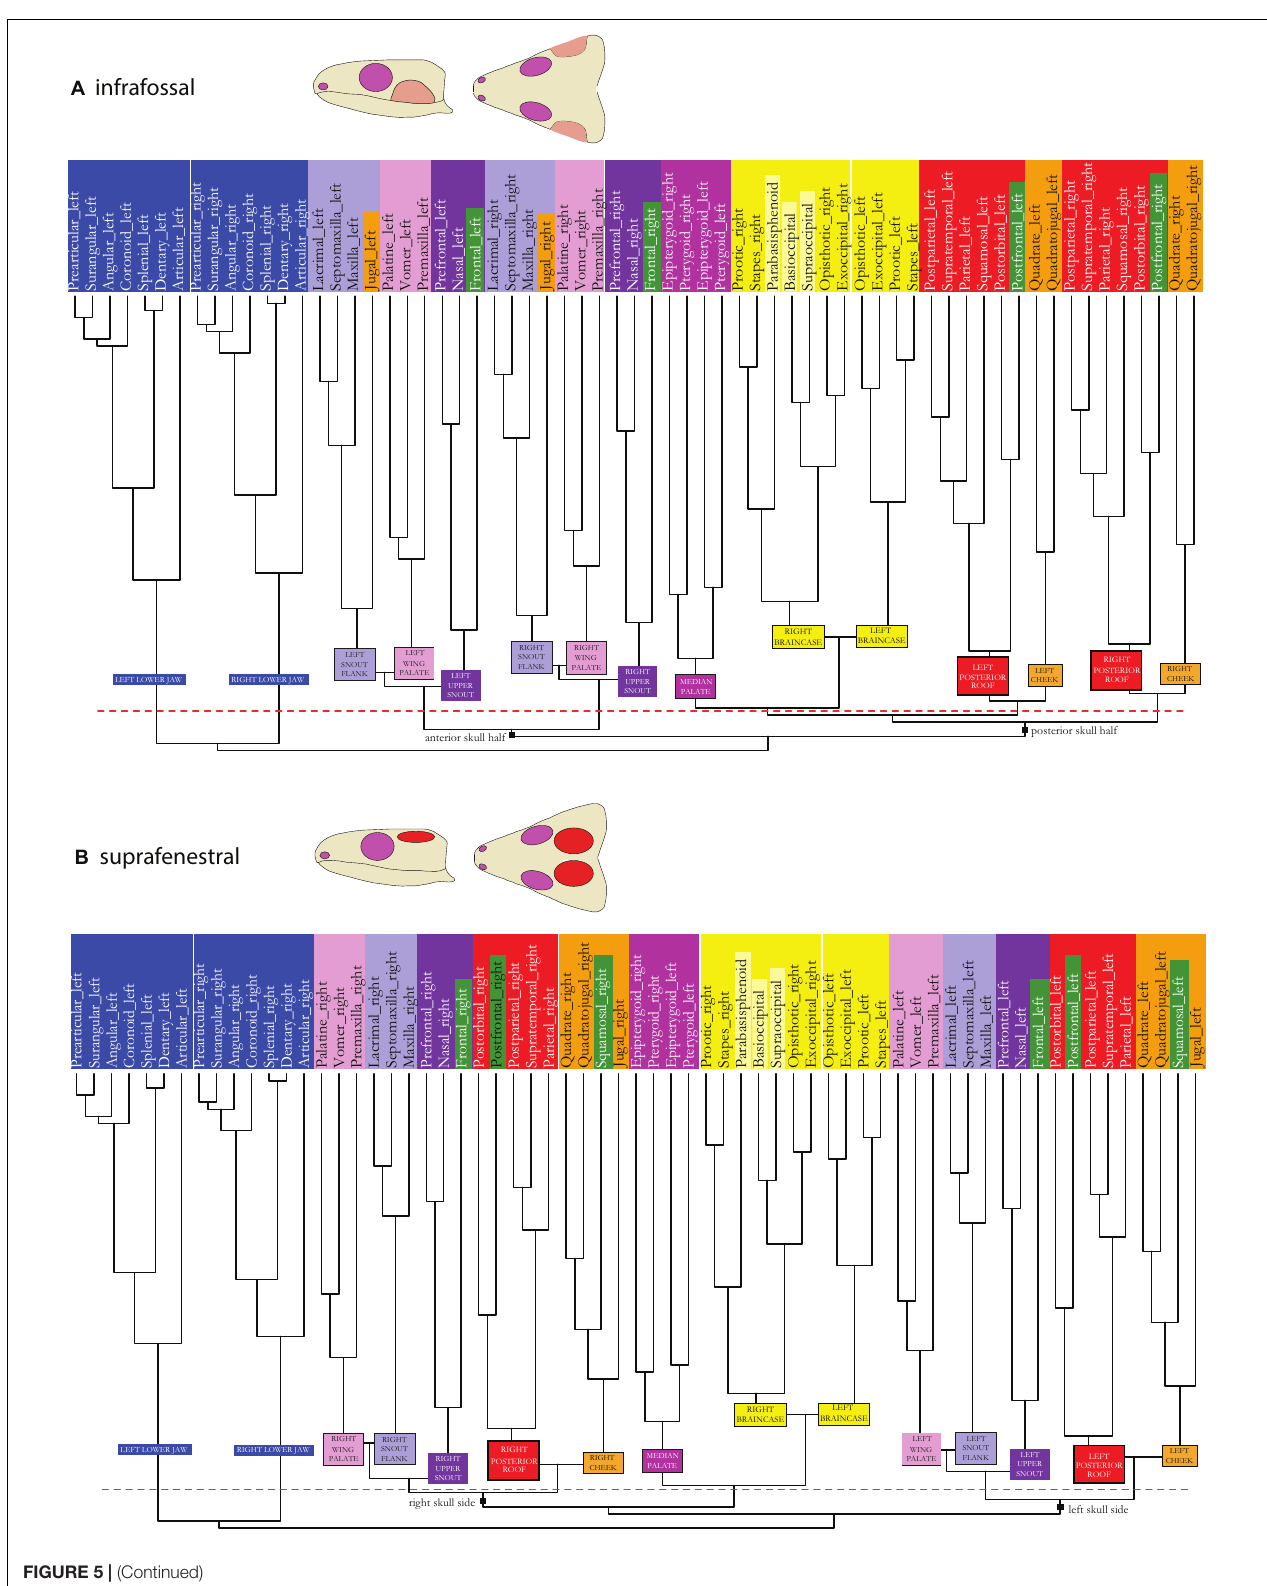
LEFT BRAINCASERIGHT